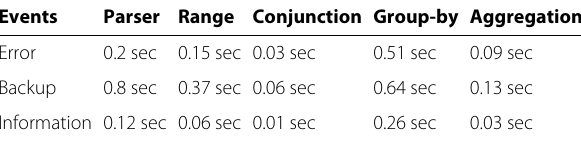
Table 5 Heterogeneous stream join through query